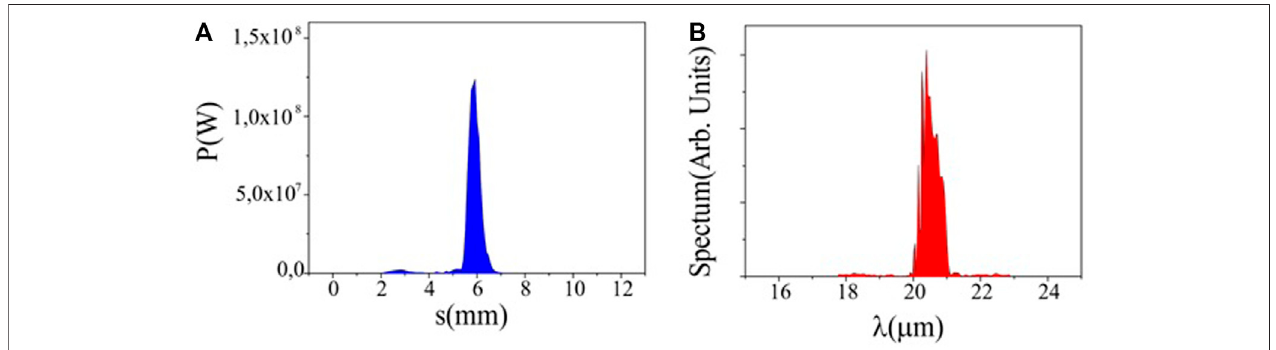
FIGURE2| RadiationpropertiesoftheTerRA@BriXSinOsource. (A) TheIntra-cavitylongitudinalpro fi leofthepowerforasingleshotof355 mJand (B) thespectral pro fi le, when the two undulators (TU&IO) are in tune for an emission wavelength of λ = 20 μ m at the saturation point of the oscillator.